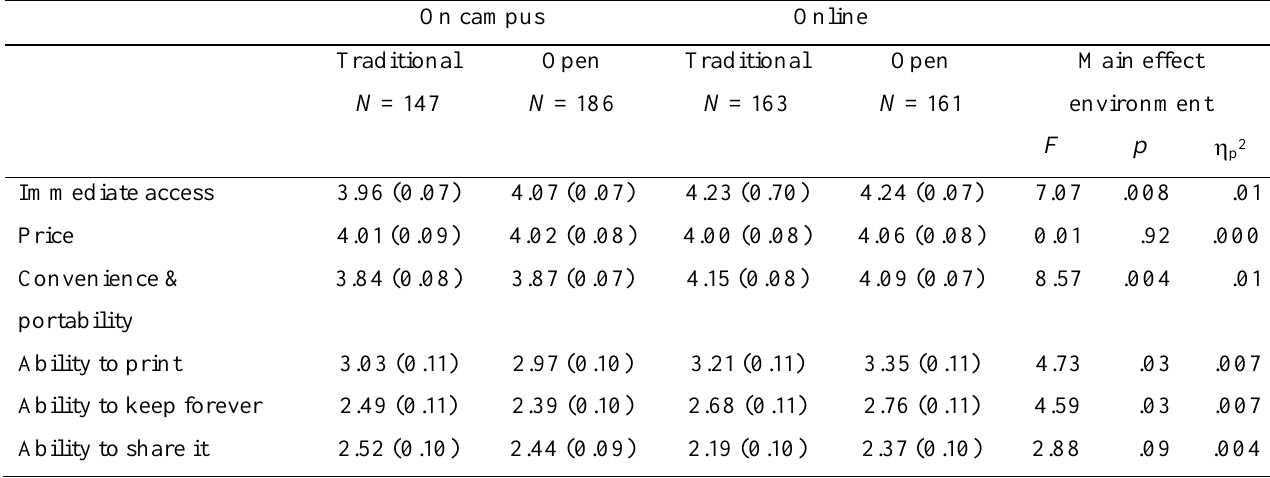
Ratings of the Importance of Various Features of Textbooks across the Four Groups On